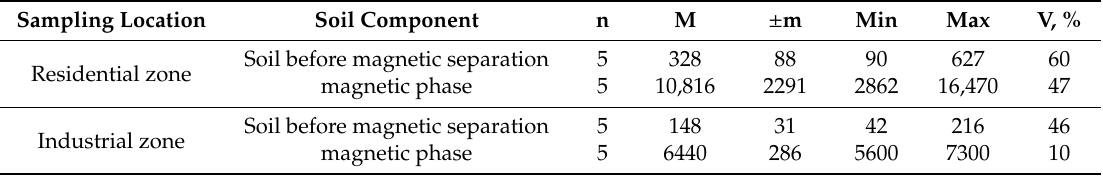
Table 8. Statistical indicators of the magnetic susceptibility of soil and magnetic phase of the upper soil horizons (0–10 cm) of Gubakha ( p =